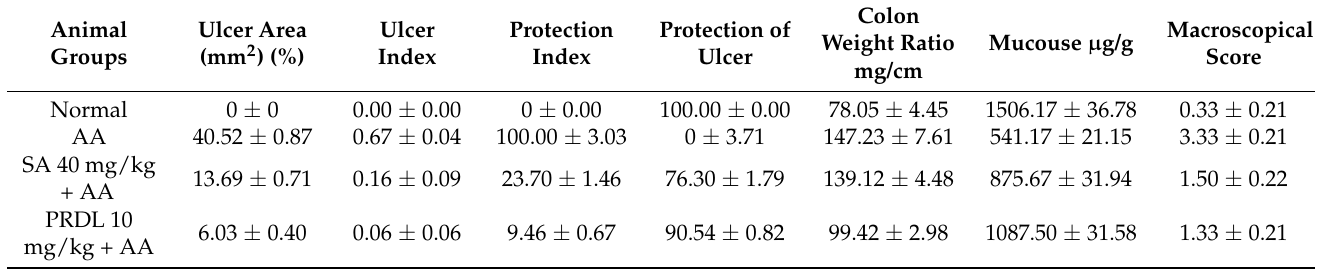
Table 2. Effects of SA and PDRL on the macroscopic parameters of ulcerative colitis induced by acetic acid in rats.